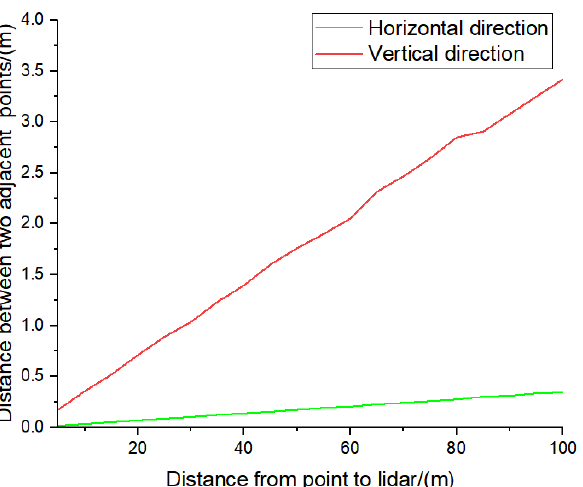
Machines 2023 , 11 , x FOR PEER REVIEW Figure 6. Horizontal and vertical distance between two adjacent points at 0 – 100 m from lidar. Figure 5. Horizontal and vertical distance between two adjacent points at 0–100 m from lidar.